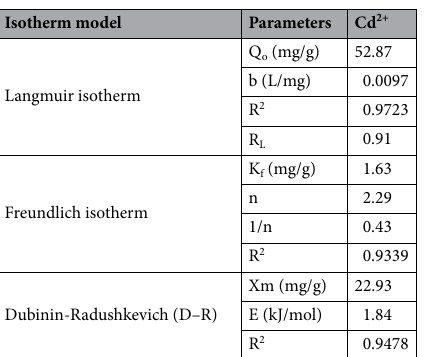
Figure 4. Langmuir ( a ) and Freundlich (b) isotherm models of cadmium ions. Isotherm model Parameters Cd